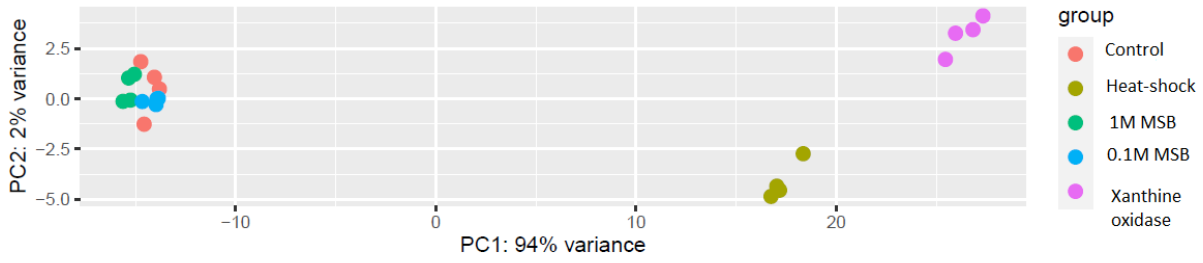
Figure 3. PCA of the RNA-Seq data after rlog transformation.